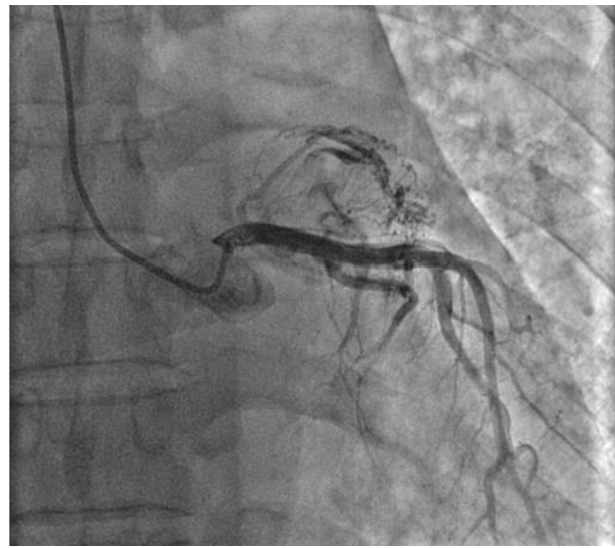
Fig. 2 – Antero-posterior oblique projection of left coronary angiogram revealed coronary artery fistulae drained into the left atrium with two terminal